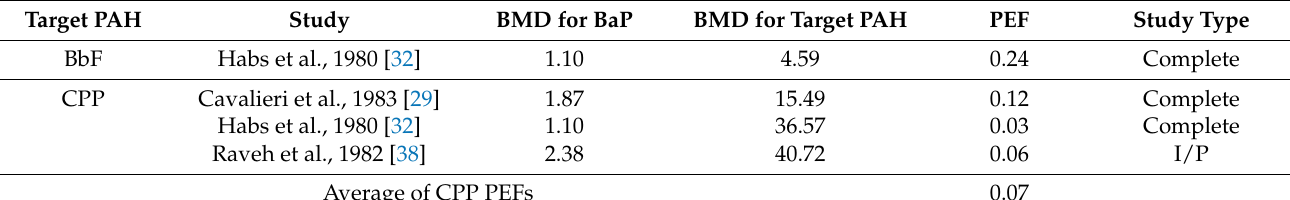
Table 7. Summary of PEF Calculations from Dose Response